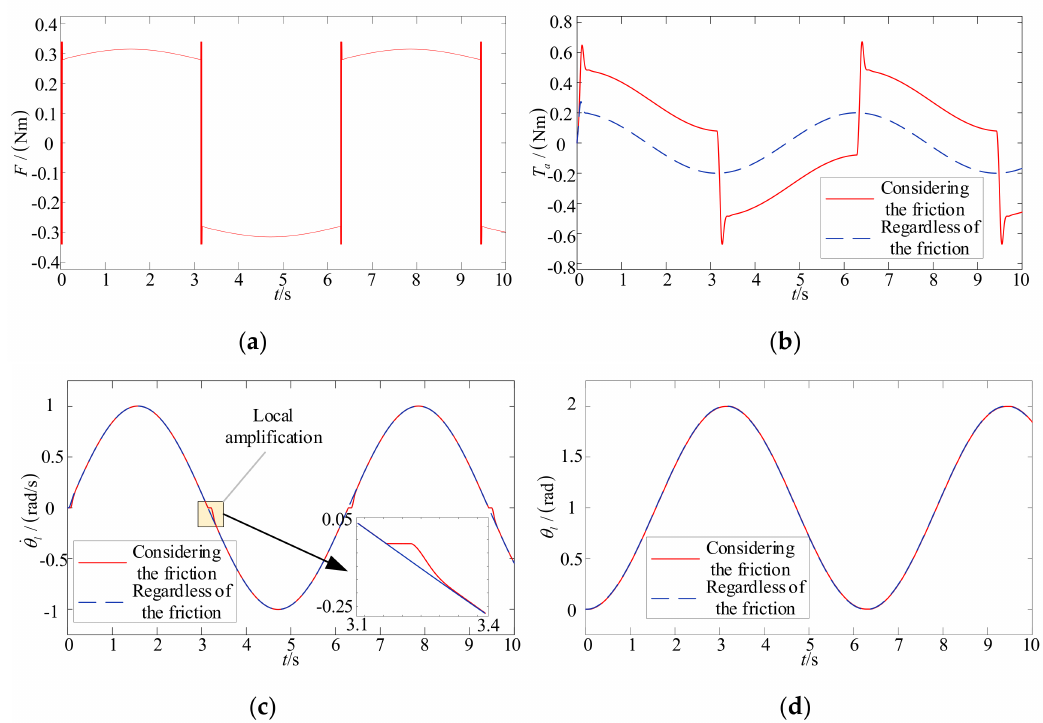
Figure 10. The influence of friction torque on the system. ( a ) Image of friction torque ( b ) Influence of friction torque on required input torque. ( c ) Influence of friction torque on load speed ( d ) Influence of friction torque on load